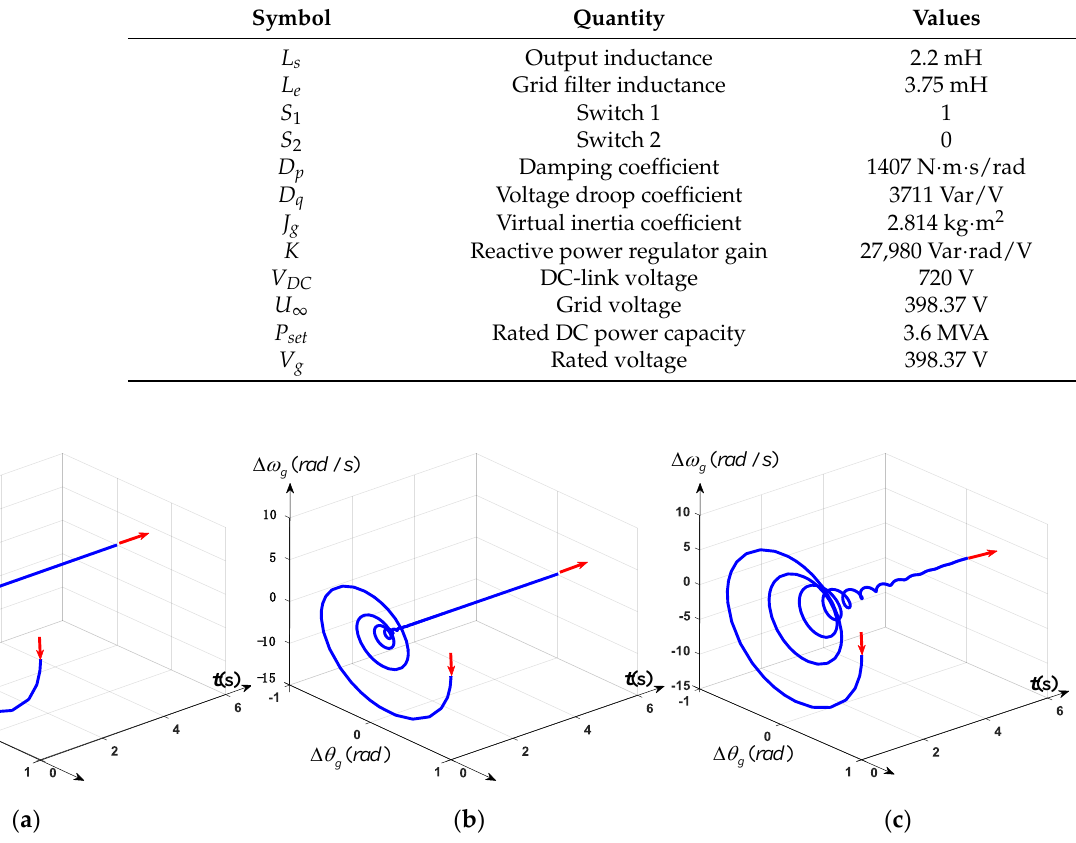
Figure 16. Internal voltage dynamics with different grid strengths: ( a ) SCR = 15.4; ( b ) SCR = 2.5; ( c ) SCR = 0.65.